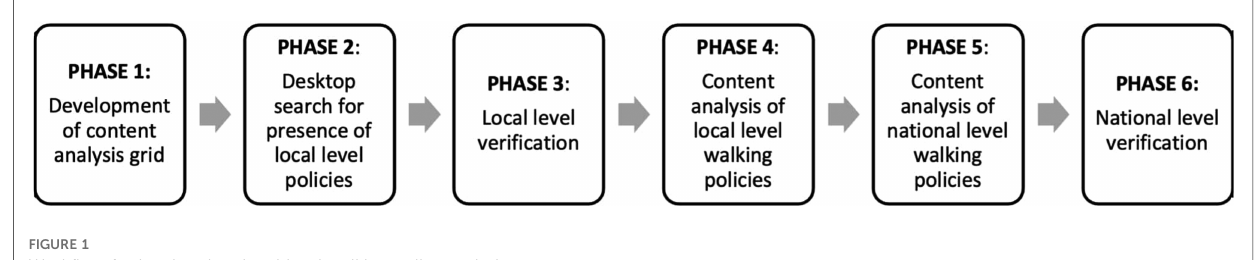
FIGURE 1 Work fl ow for local and national level walking policy